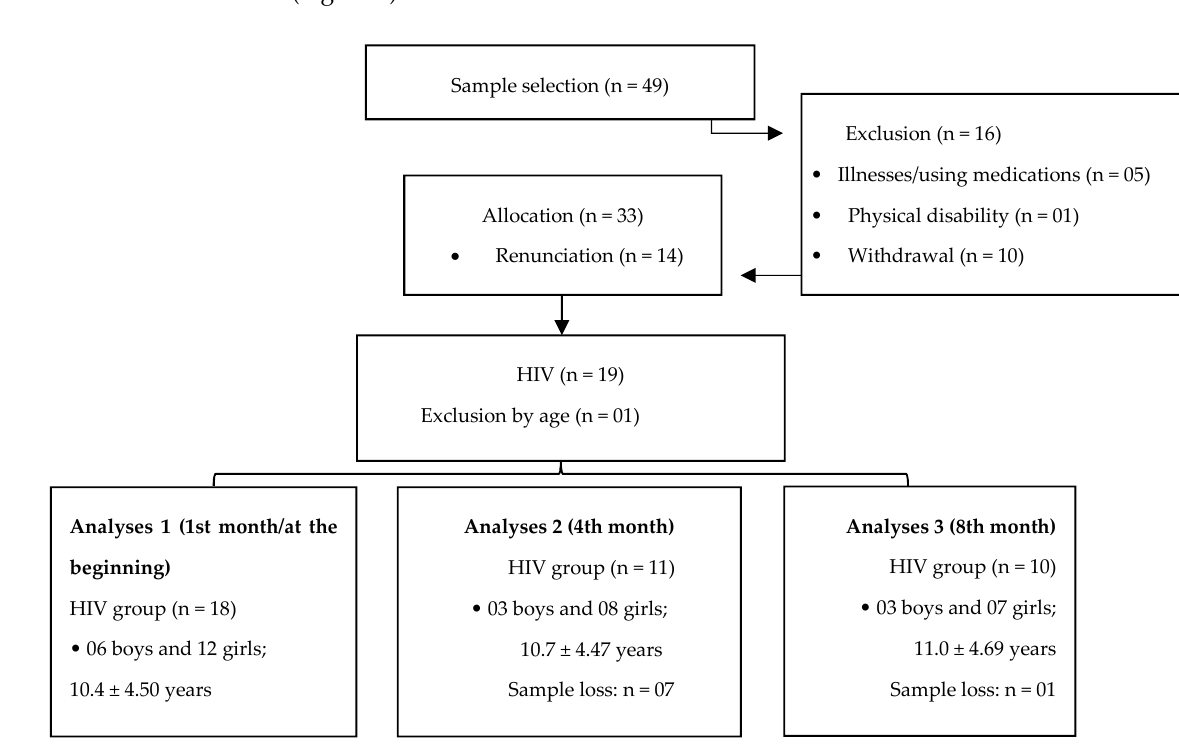
Figure 1. Study flowchart.